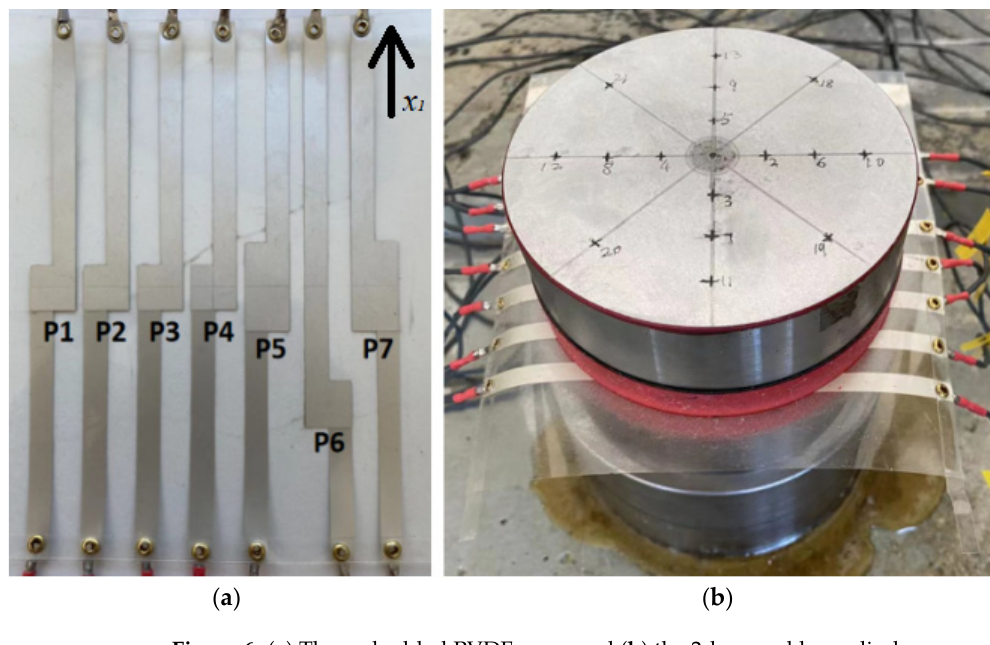
Figure 6. ( a ) The embedded PVDF array and ( b ) the 2-layer rubber cylinder.